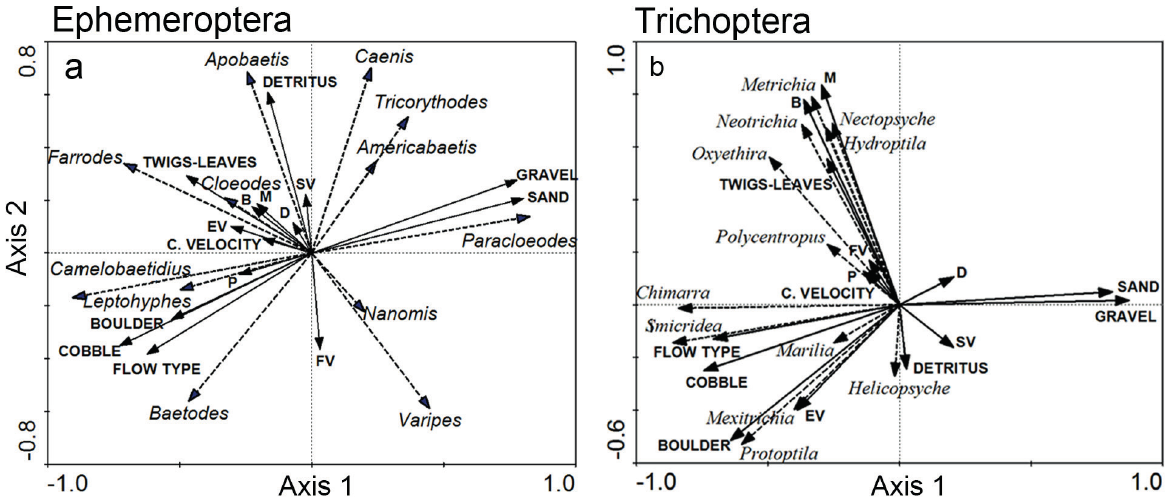
Figure 5 - RDA of ephemeroptera ( a ) and Trichoptera ( b ) with environmental variables from different habitats of the study streams (Carcarañá River upper Basin, Córdoba, Argentina). Dashed arrows correspond to genera and solid arrows correspond to habitat